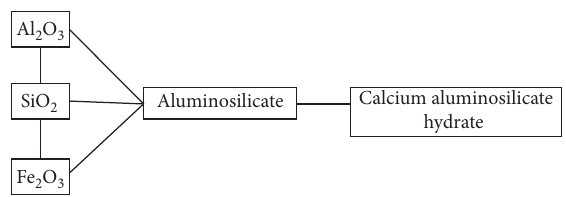
Figure 3: Organic reaction part of pozzolanic